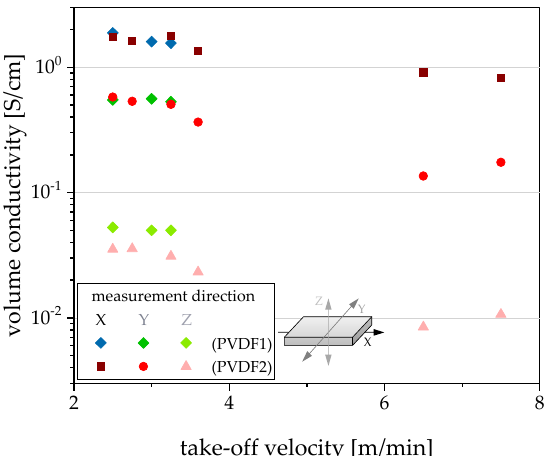
Figure 9. Direction-dependent electrical volume conductivity in dependence on take-off velocity during film extrusion for PVDF/1 wt % b-MWCNTs + 3 wt % CB composites.